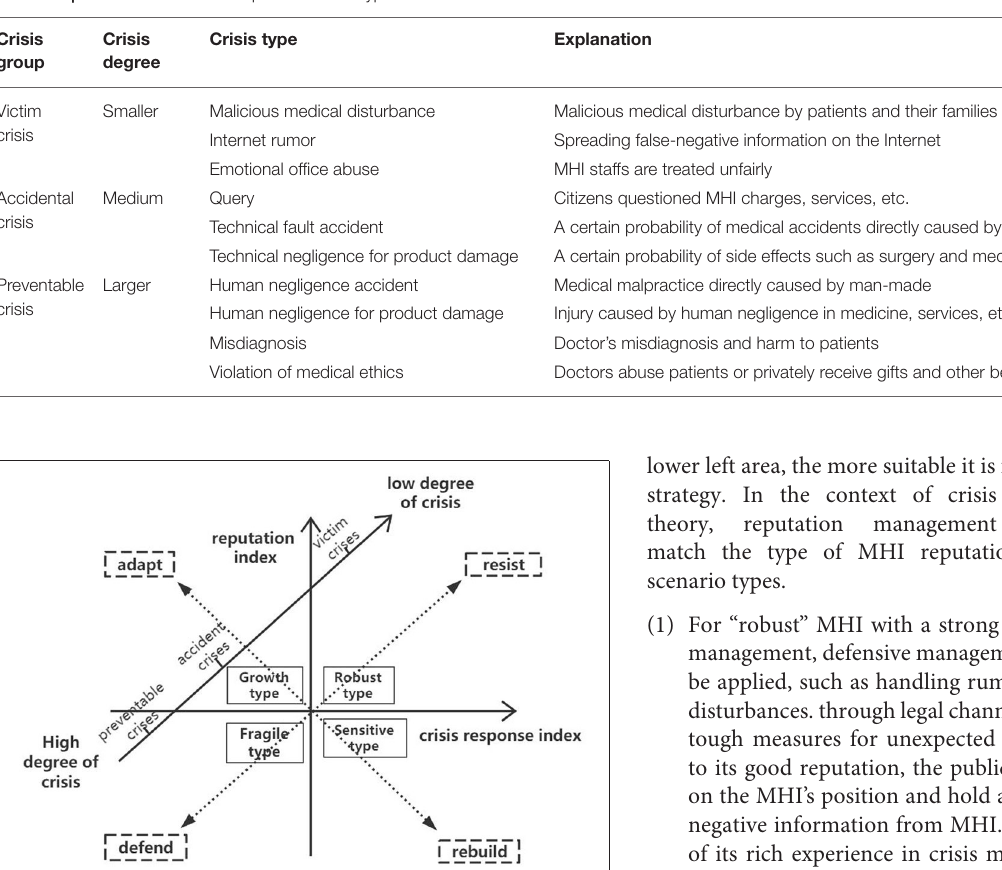
TABLE 4 | Classification of MHI reputation crisis types.